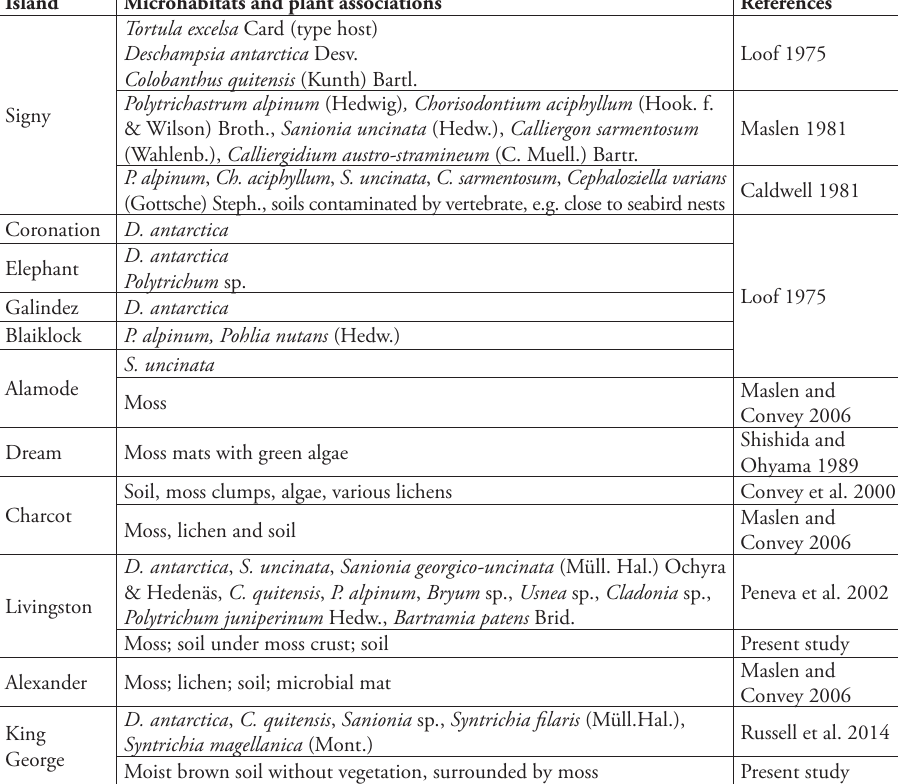
Table 6. Distribution of Enchodeloides signyensis gen. n., comb. n. in Antarctic islands and habitats. Island Microhabitats and plant